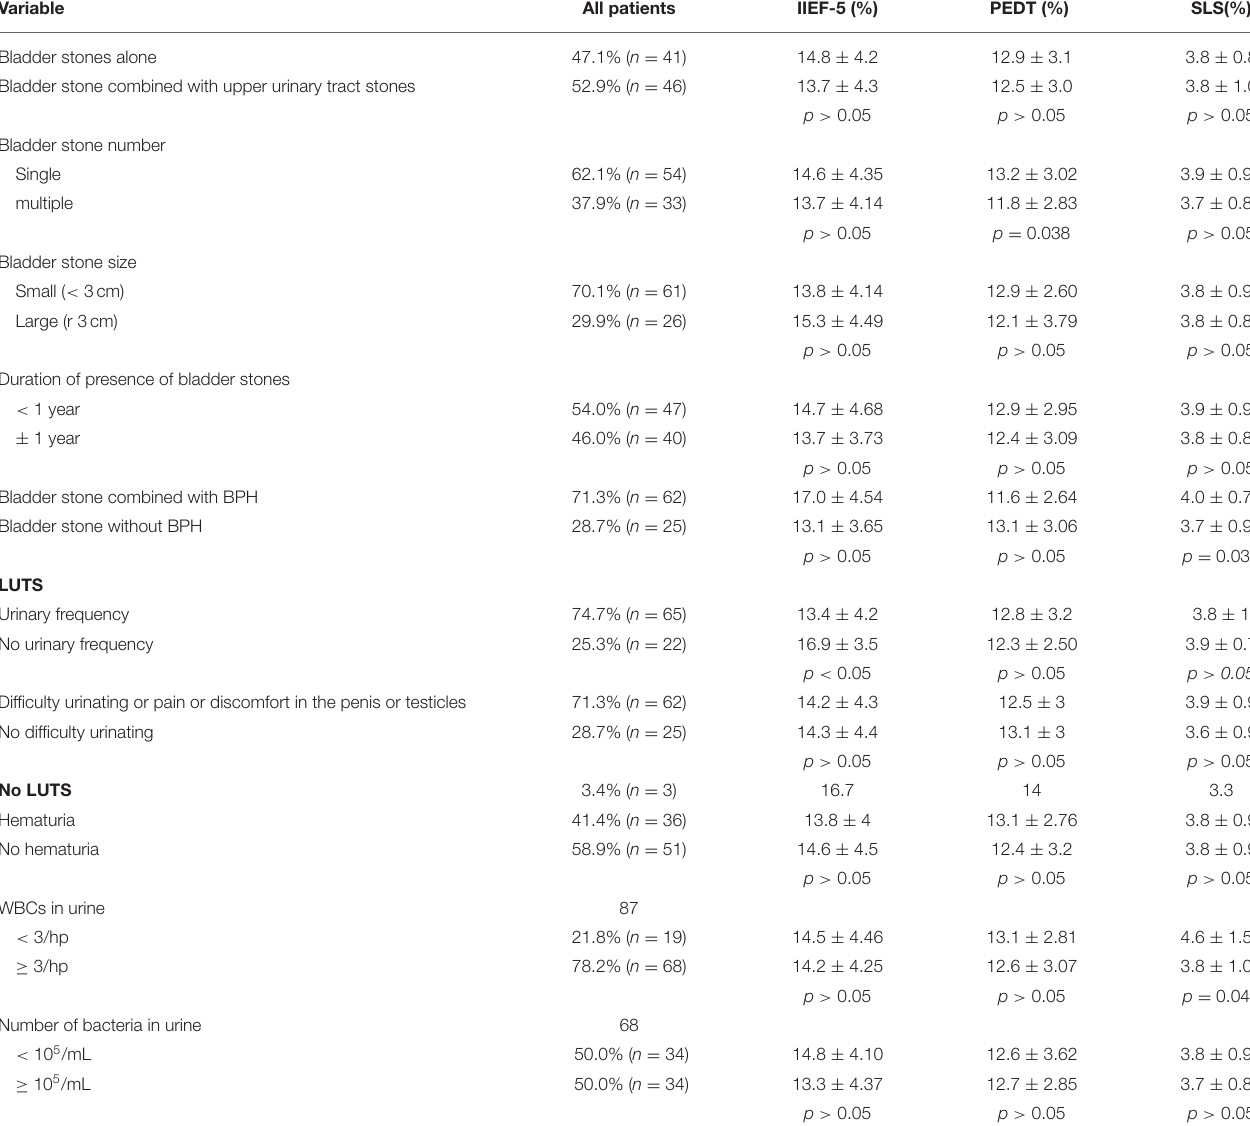
TABLE 2 | Relationship of bladder stones with sexual dysfunction or LUTS. Variable All patients Bladder stones